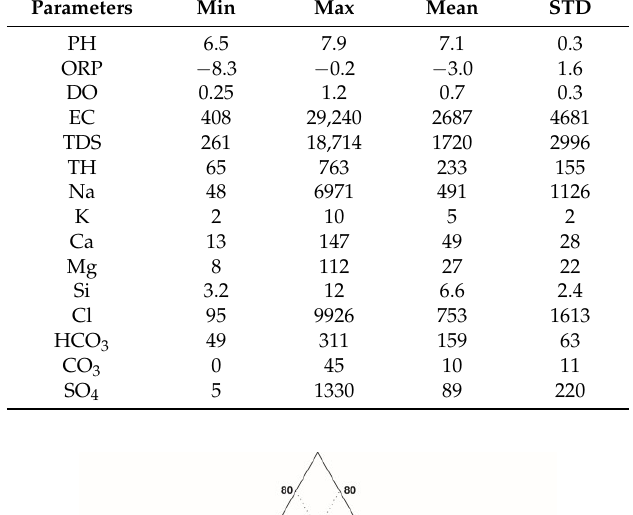
Table 1. Descriptive statics of analyzed parameters in the groundwater.